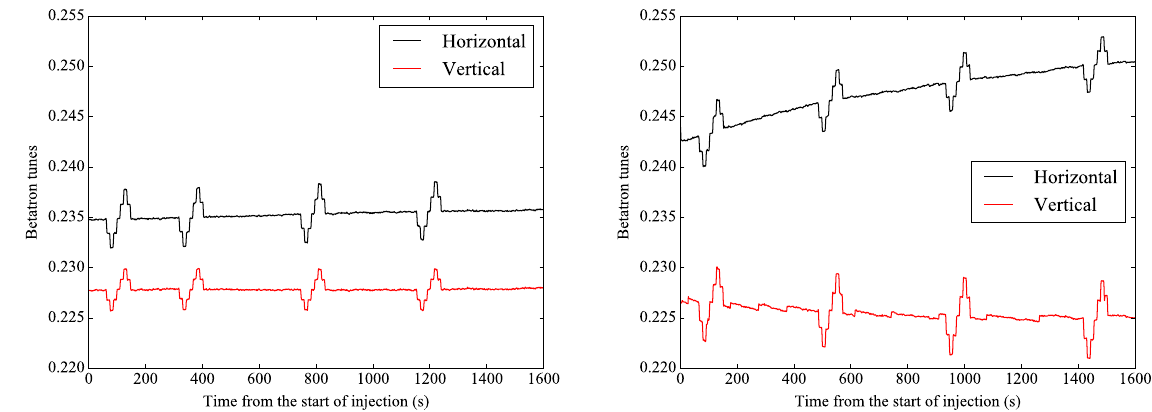
FIG. 9. The left plot shows the drift of the horizontal and vertical betatron tunes after the demagnetization cycle. The right plot shows the drift of the horizontal and vertical betatron tunes after the conventional cycle. The sawtoothlike excursions of the betatron tunes resulted from the rf frequency changes used to measure